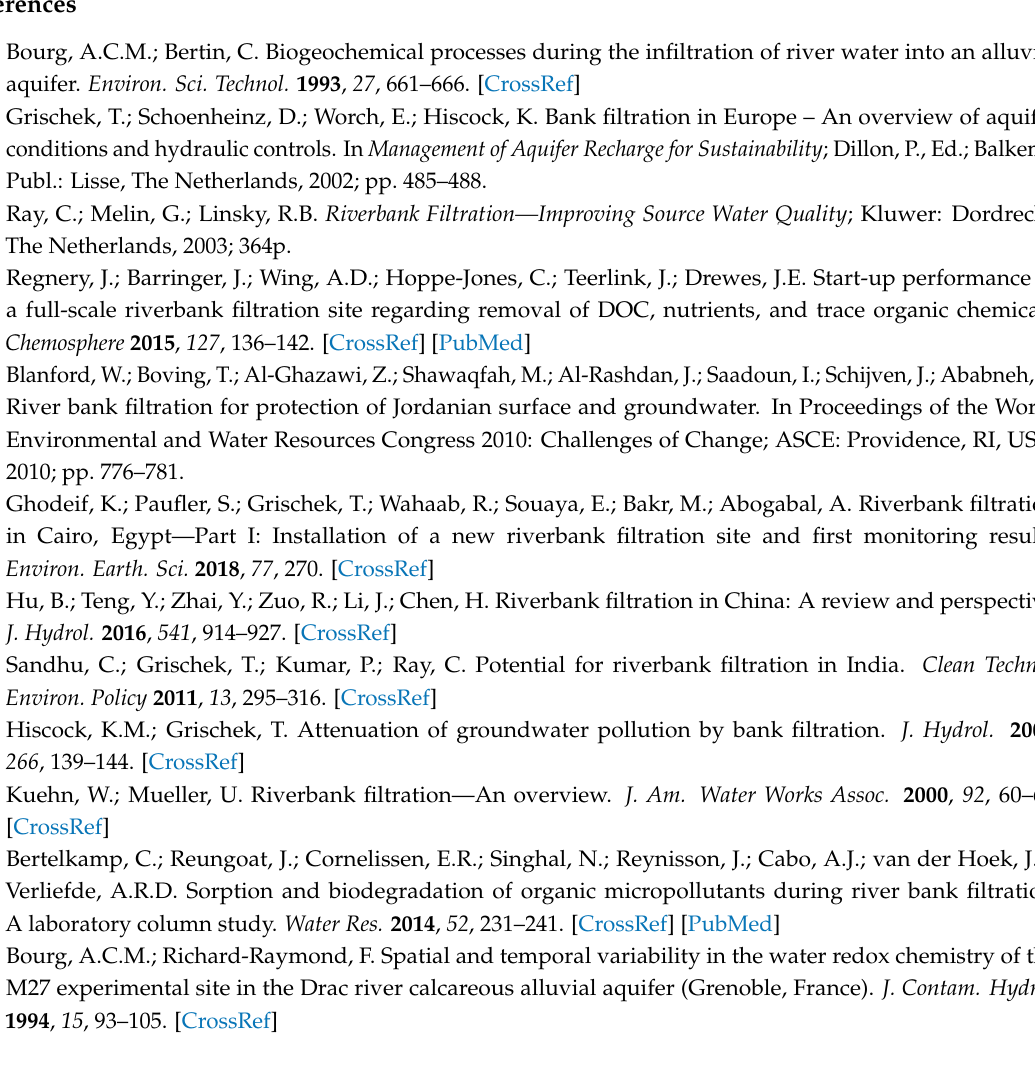
Table S6: The statistical data for Mn release during the column experiment with riverbed sediment from the Elbe river in Dresden-Tolkewitz, Q 1 and Q 3 correspond to the 1st and 3rd quartile; • Table S7: The comparison of the measured parameter values during the column experiment and the modeled parameters from PHREEQC; Table S8: The results and statistical data of the sequential extraction of the riverbed sediment after the column experiment ( n = 3 for each statistical data); Table S9: The median concentration of DO in the outflow during the column